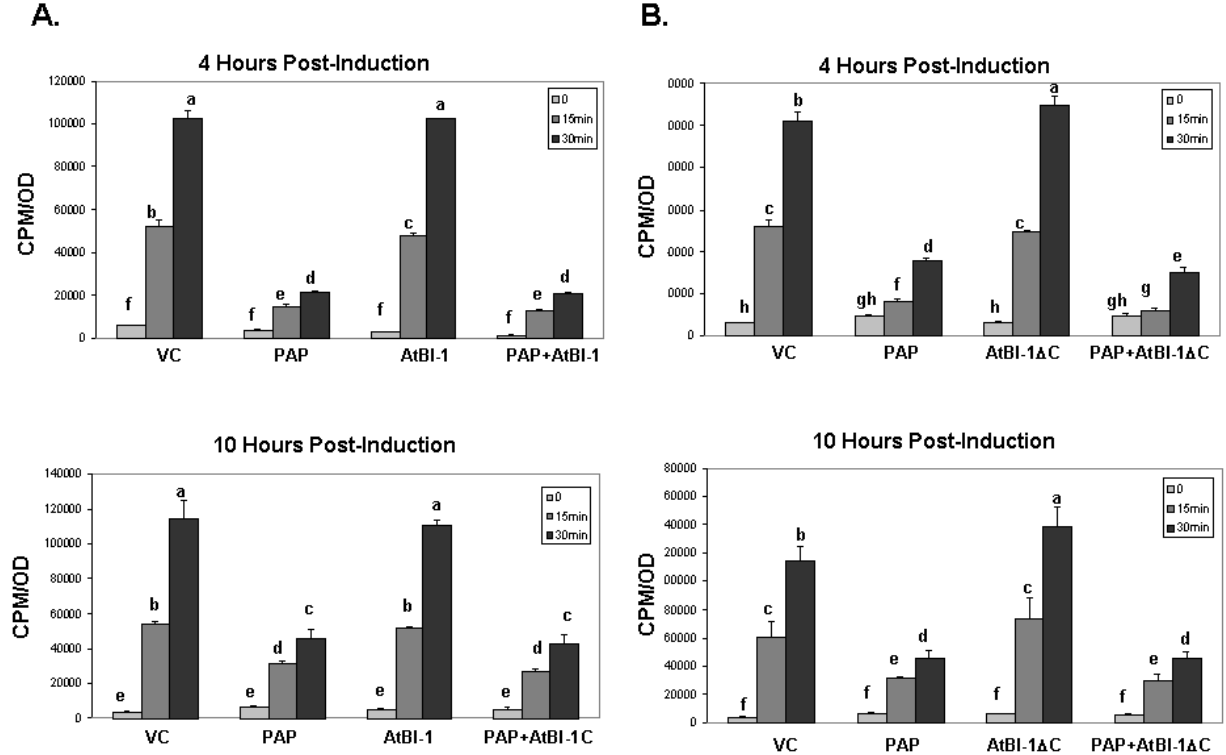
FIGURE 5 : Analysis of total translation in yeast cells. (A) Total translation in yeast cells expressing PAP and AtBI-1. (B) Total translation in yeast cells expressing PAP and AtBI-1ΔC. Yeast cells were grown in SD-L-U-Met and 2% glucose overnight then switched to 2% galactose con- taining media to induce the expression. At time 0, [ 35 S] methionine was added to cells growing on galactose which expressed PAP or AtBI-1 and incorporation of [ 35 S] methionine was determined at the indicated times. Each point was repeated in duplicate. The results represent three independent experiments. VC - vector control. Columns are statistically different according to ANOVA (P < 0.001) followed by a post- hoc Fisher's Least Significant Difference (LSD)